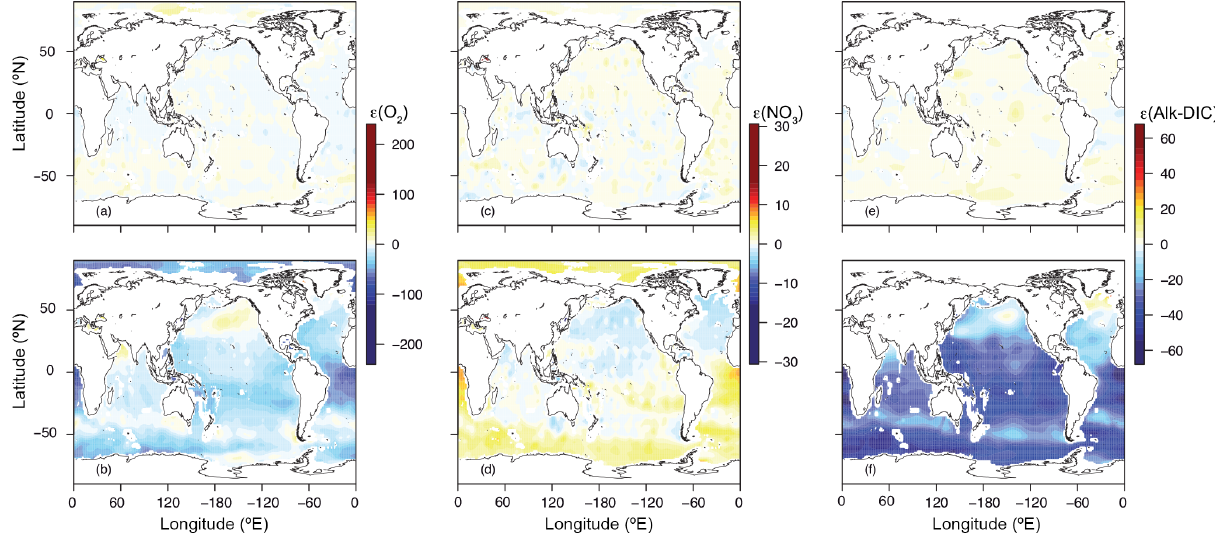
Figure 6. As Fig. 4 but for concentrations at 2000m. Note that color shading does not represent the same amplitude in spatial biases as in Figs. 4 and